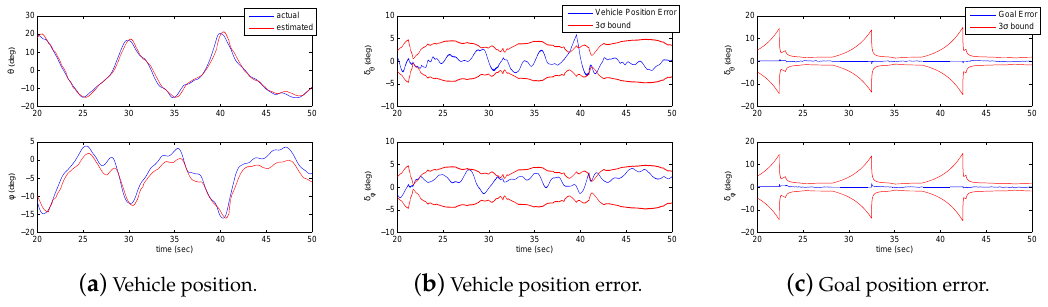
Figure 19. Results for the vehicle and goal position estimation using the gaze data as